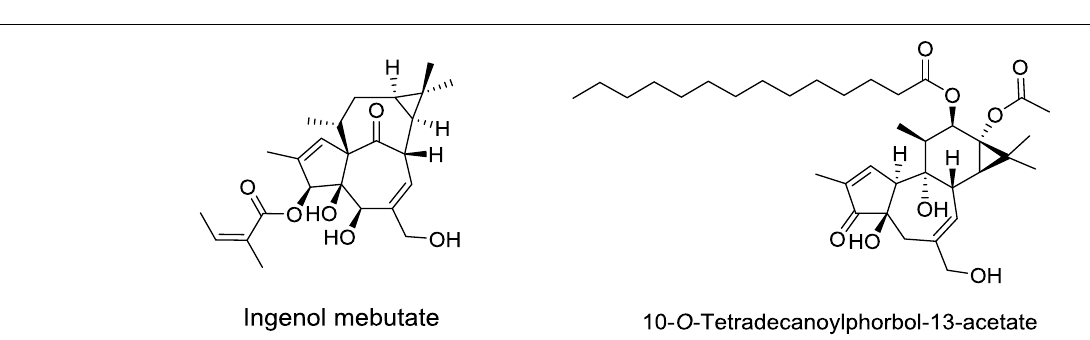
agent, chloranbucil, conjugated to an antibody against a mouse lymphoma (Ghose et al., 1975). The advent of monoclonal